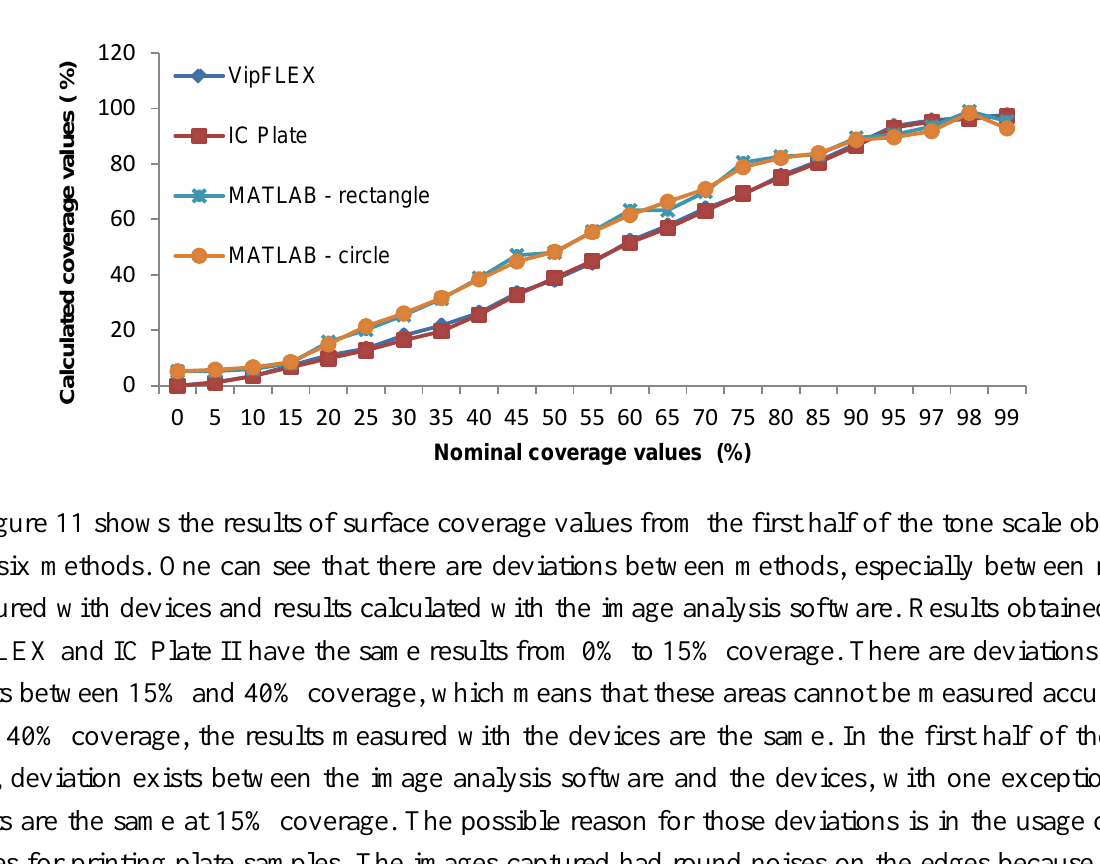
Figure 11. Comparison of nominal and measured coverage values obtained with different methods, 0% to